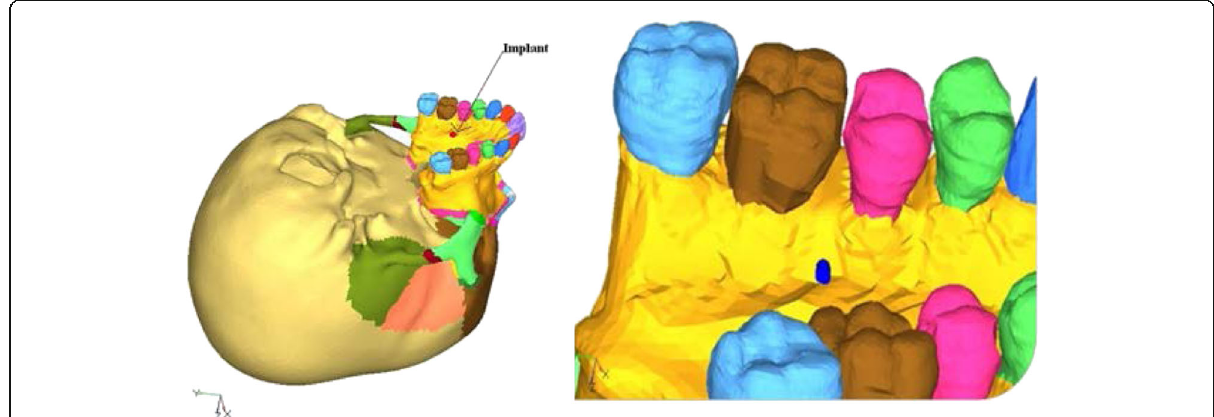
Fig. 2 Geometric model with implant embedded in the